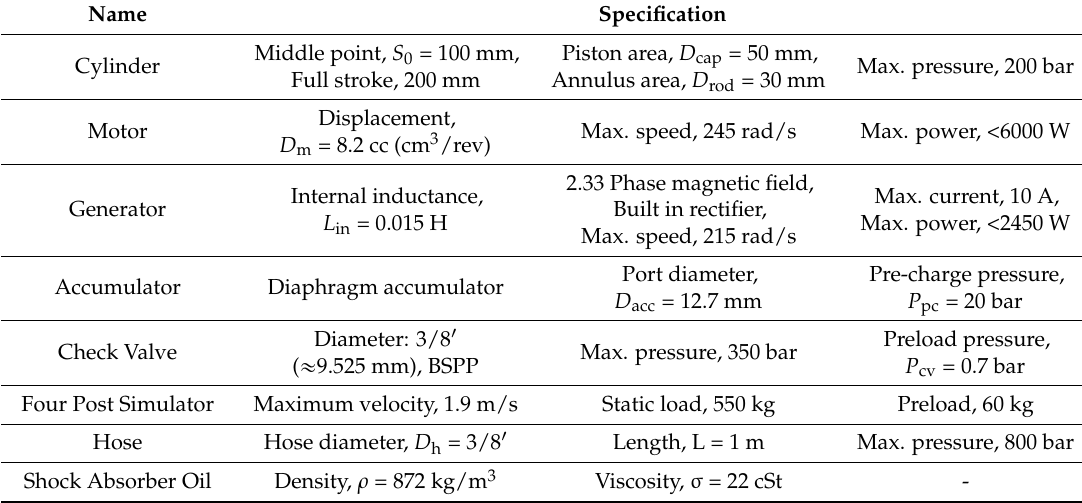
Table 1. The specifications of main